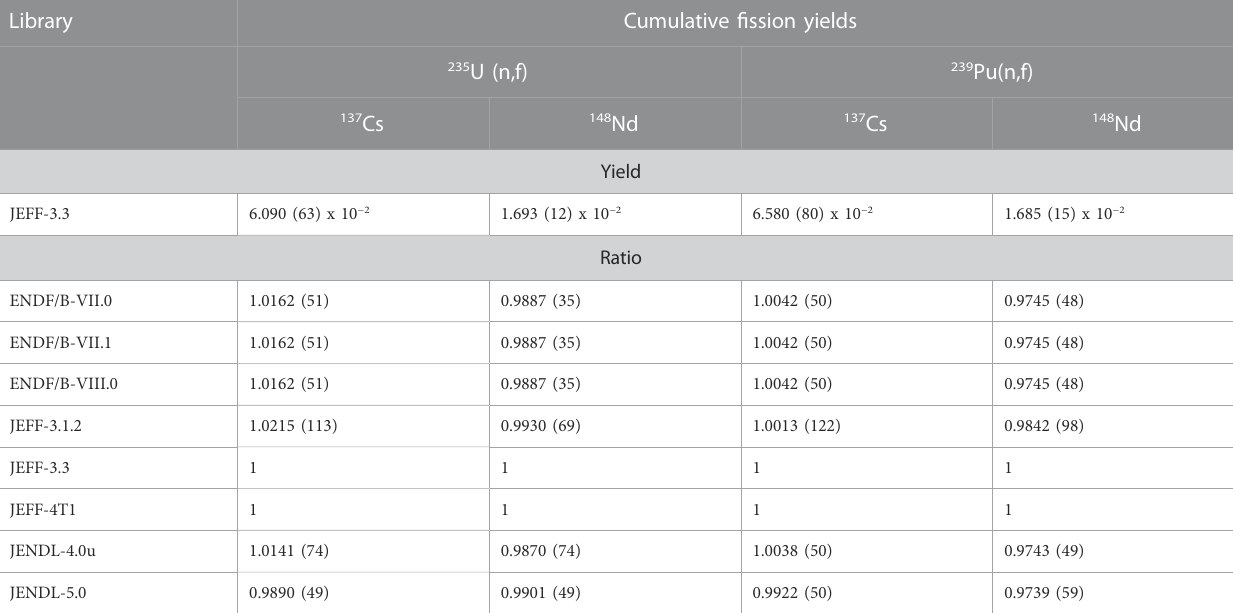
TABLE6Cumulative fi ssionyieldsfor 137 Csand 148 Ndforneutroninduced fi ssionof 235 Uand 239 Pubythermalneutronsadoptedindifferentdatalibraries.Thevalues derived from the JEFF-3.3 library are given together with the values derived from other libraries relative to those of JEFF-3.3.